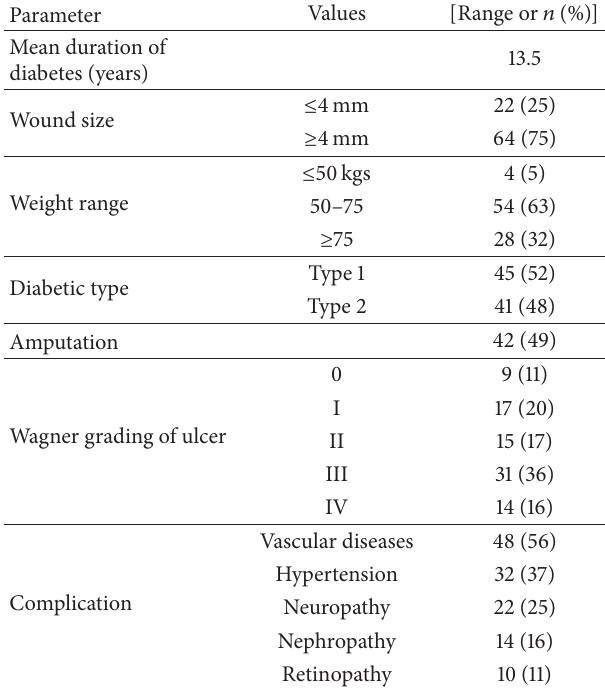
Table 1: Demographic and clinical data of diabetic foot patients. Table 2: Frequency of organisms isolated from diabetic foot patients.